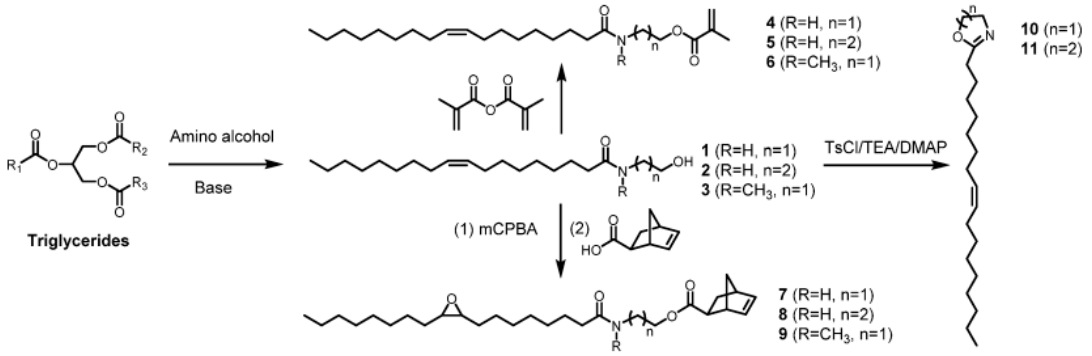
Figure 1. Transformation of triglycerides in N-hydroxyalkylamides and methacrylate monomers. Reprinted with permission from [16]. Copyright (2015) American Chemical Society.